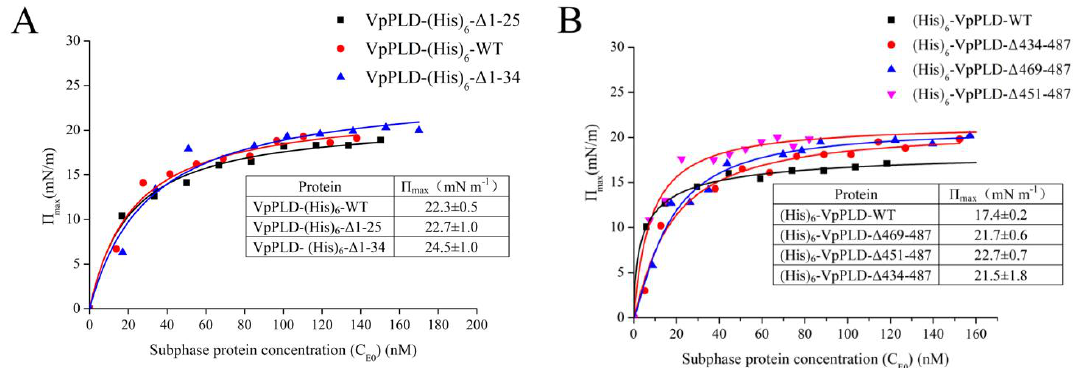
Figure 4. Increase of the surface pressure as a function of subphase protein concentration (C E0 ) in the absence of a phospholipid monolayer. ( A ) Wild-type VpPLD (VpPLD-(His) 6 -WT) and its N-terminal truncated mutants. ( B ) Wild-type VpPLD ((His) 6 -VpPLD-WT) and its C-terminal truncated mutants. Wild-type VpPLD and its corresponding N- and C-terminal truncated mutant proteins at different concentrations were injected beneath an air–water interface, and the surface pressure increase was recorded until equilibrium. The maximum surface pressure increase (Π max ) was then obtained for each sample. Buffer used for the sub-phase: 50 mM Tris-HCl, pH 8.0. For the detailed method, please see Section 3.5.